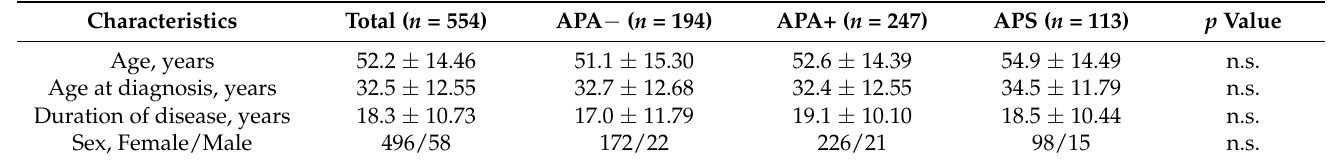
Table 1. Demographic characteristics of the subgroups of SLE